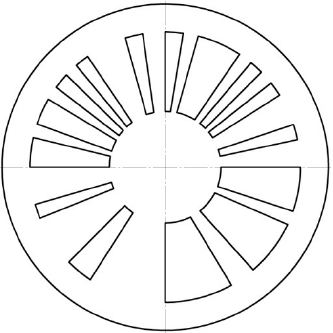
Figure 7. Placement of windows on the rotor of the pneumatic system: m = 59.